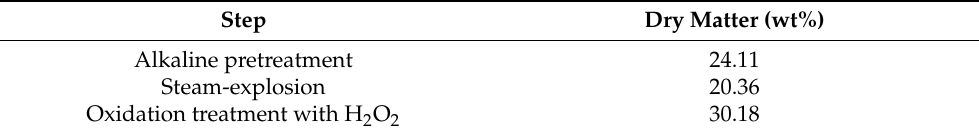
Table 6. Dry matter content of generated solutions after each